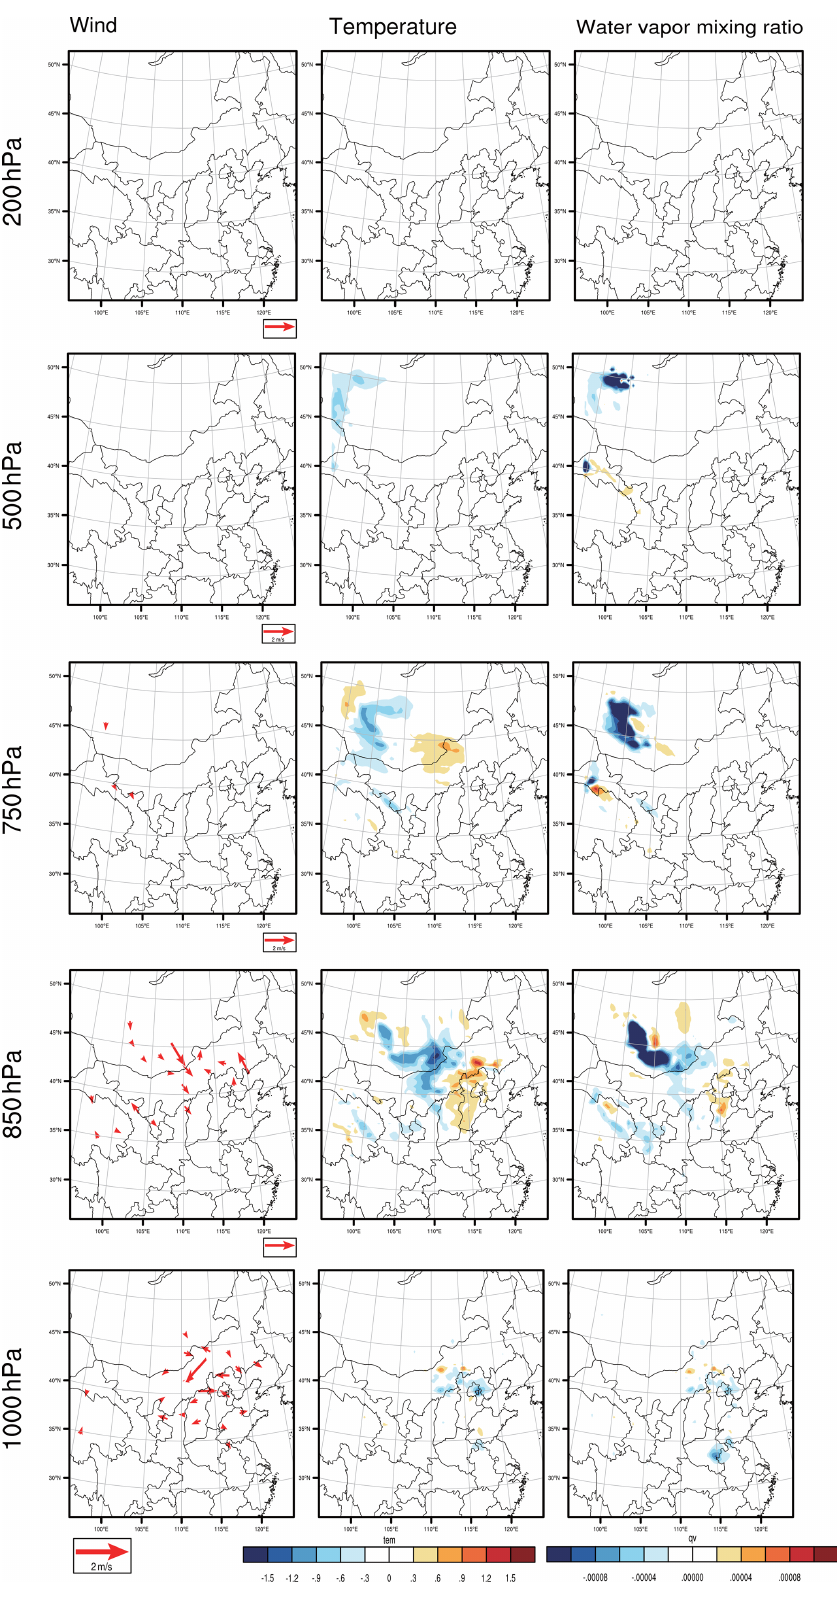
Figure 5. The same as in Fig. 3 but for the forecast starting from 14:00BJT on 2 December, with a lead time of 24h.